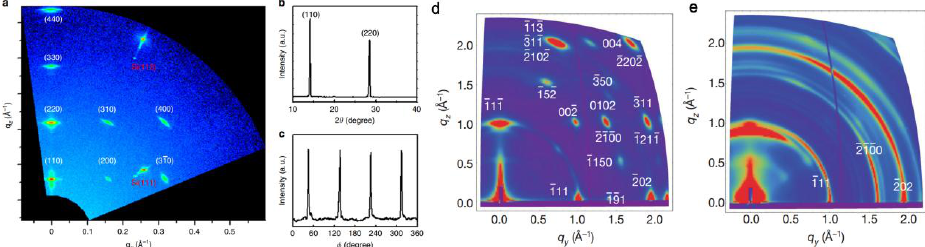
Figure 6. ( a ) 2D XRD of single-crystal patterned perovskite thin films prepared by the geometrically confined lateral crystal growth process; ( b ) Out-of-plane XRD scan. Diffraction peaks are consistent with the diffraction spots along the q z line obtained by 2D XRD; ( c ) In-plane scan obtained at the fixed angle of (002) plane. The four sharp peaks demonstrate the four-fold symmetry of tetragonal perovskite; ( d ) Hot-cast and ( e ) near-single-crystalline (BA) 2 (MA) 3 Pb 4 I 13 perovskite films with Miller indices of the most prominent peaks are shown. Color scale is proportional to the X-ray scattering intensity. The figure was taken from References [49,50] with permission.